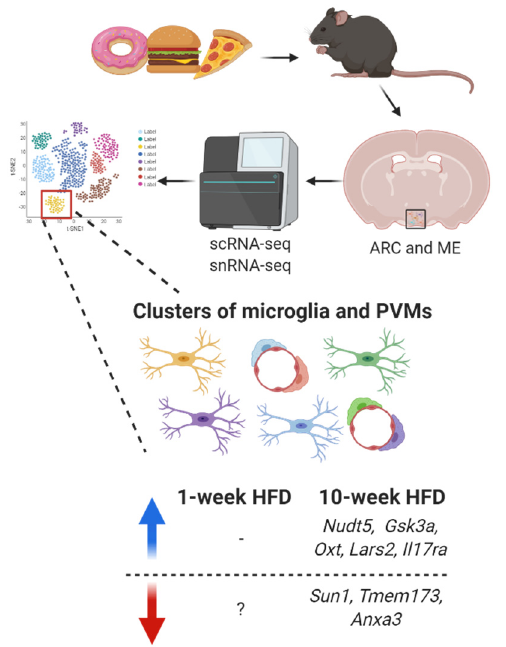
Figure 5. Transcriptomic signature changes in microglia (ramified cells) and perivascular macrophages (PVMs) (elongated cells around blood vessels) from the arcuate nucleus (ARC) and median eminence (ME) under short-term and prolonged HFD-induced hypothalamic inflammation. Blue arrow indicates upregulation while red arrow indicates